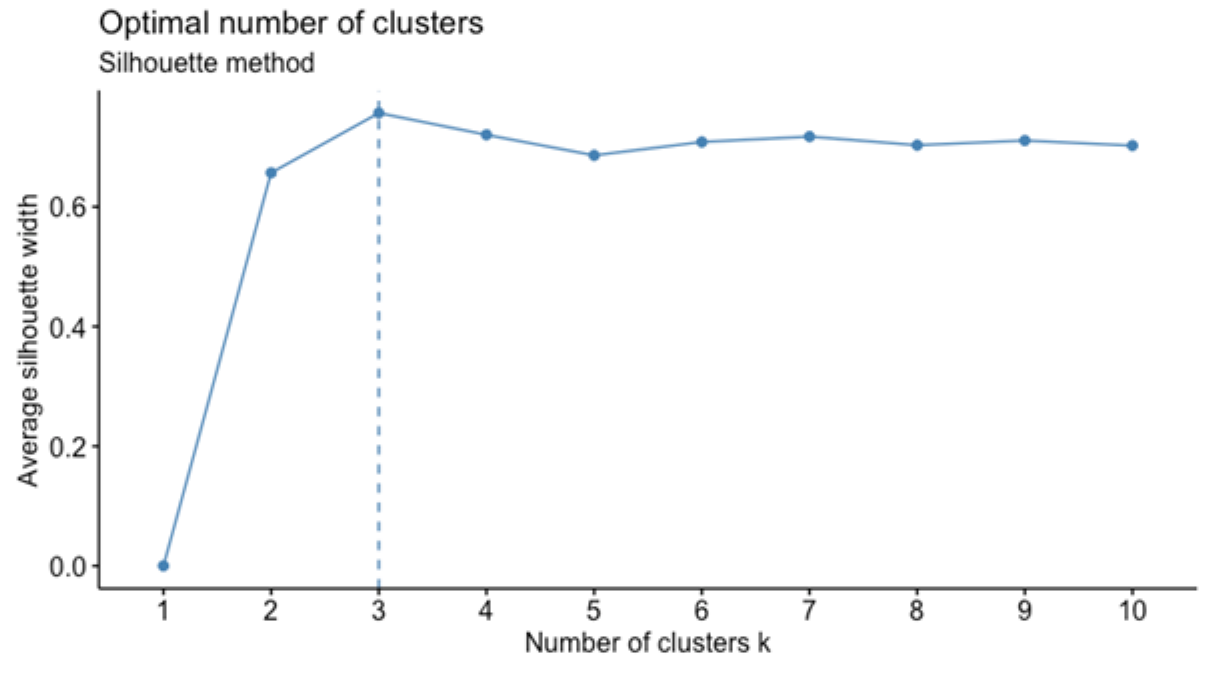
Figure 3. Silhouette statistics for choosing the optimal number of clusters: the two- or four-cluster solutions were suggested.